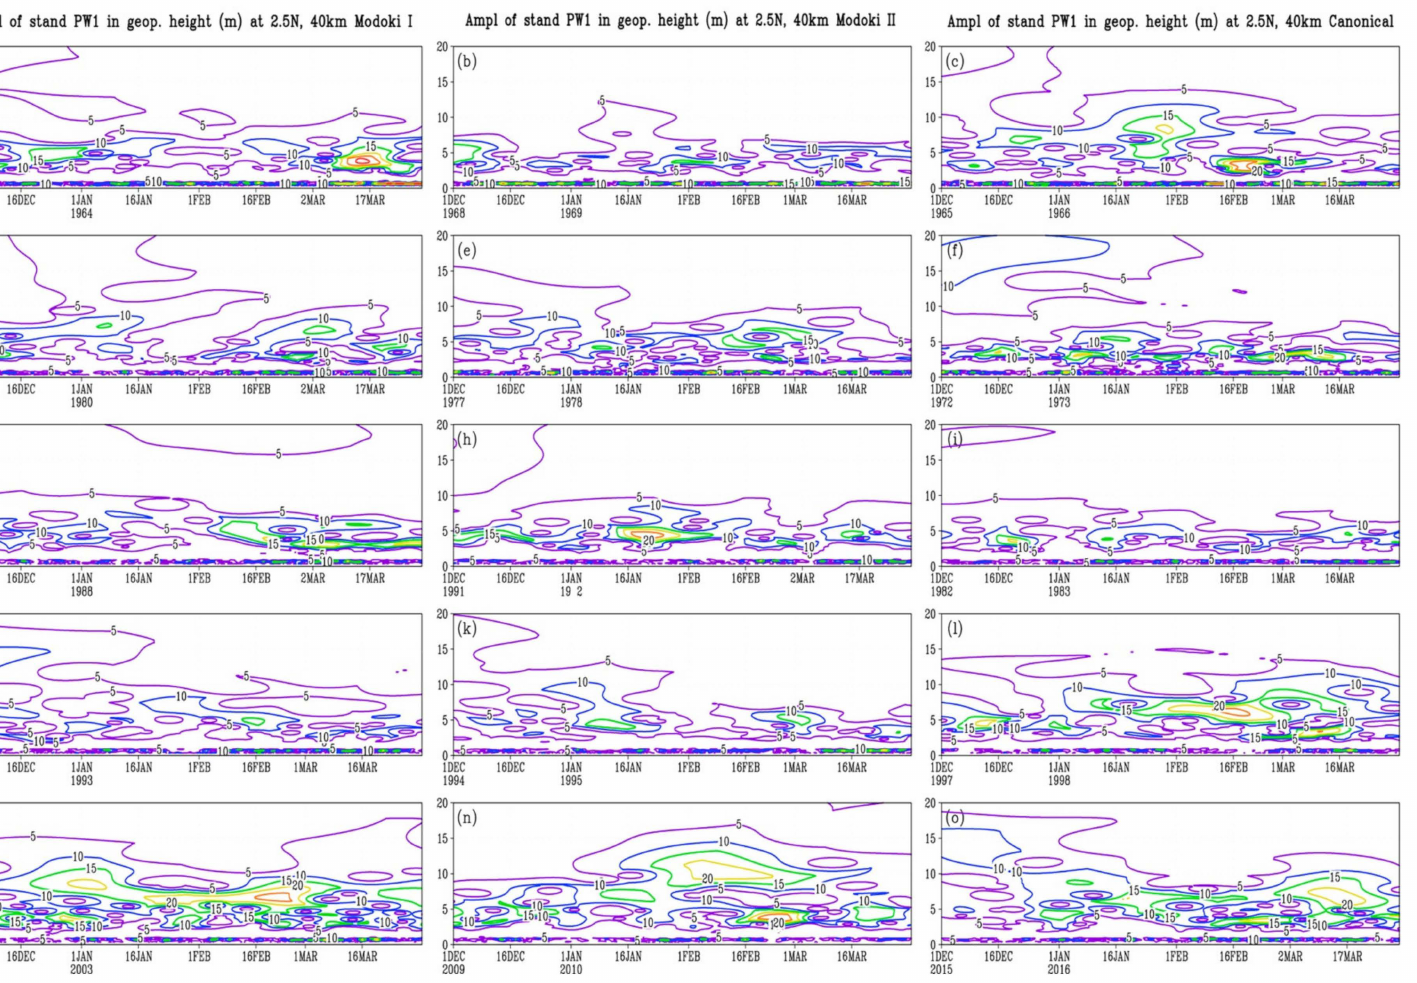
Figure 5. Amplitudes of standing planetary waves with zonal wavenumber 1 in geopotential height (m) at 62.5 ◦ N. Left panels ( a , d , g , j , m )—winters during Modoki I conditions; middle panels ( b , e , h , k , n )—Modoki II conditions; right panels ( c , f , i , l , o )—canonical